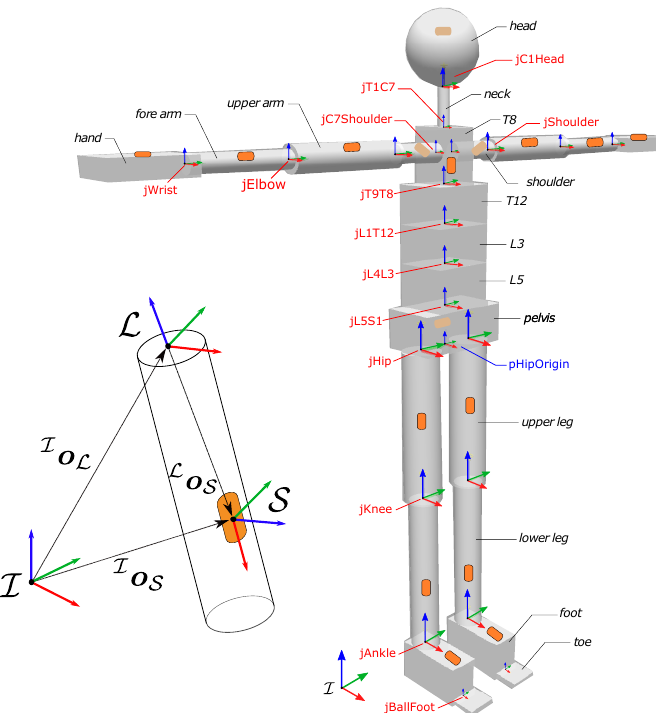
Figure 2. Human model with distributed inertial measurement units. Joint reference frames are shown by using RGB (Red–Green–Blue) convention for x – y – z -axes. (left) Detail of the sensor position on the